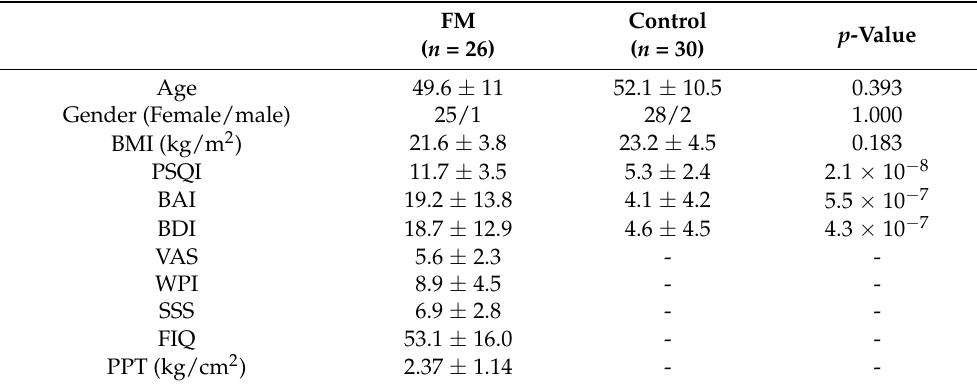
Table 1. Demographic and clinical characteristics.